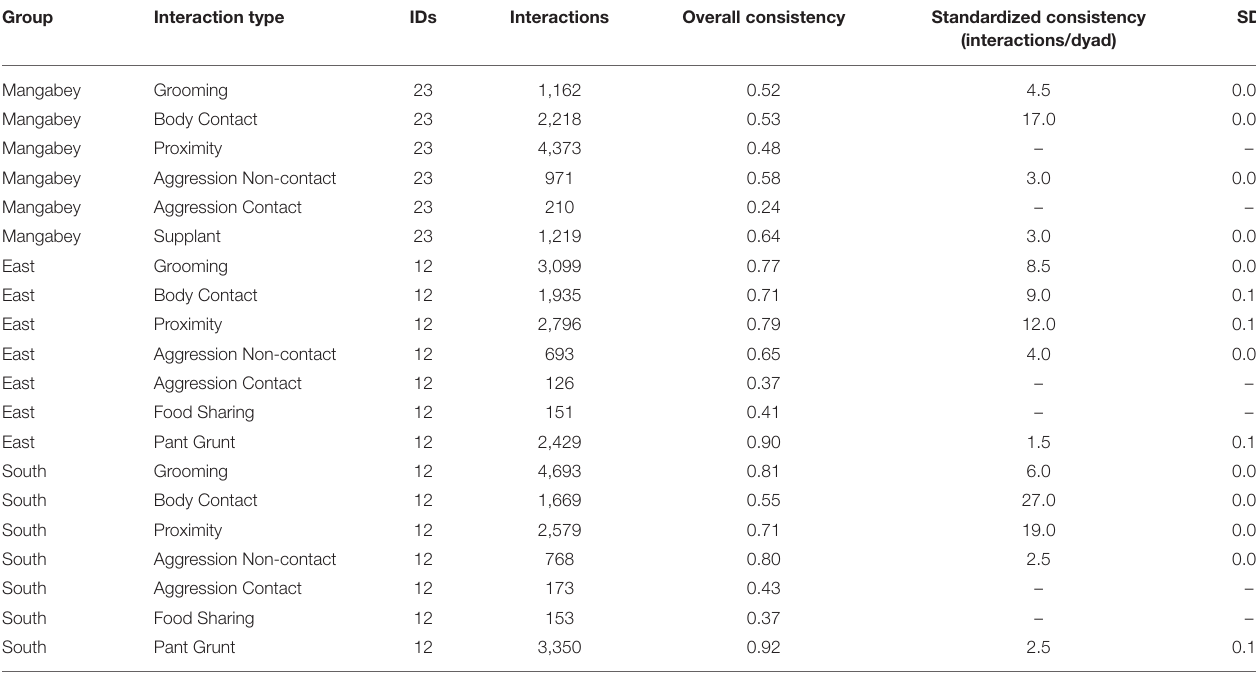
TABLE 1 | Overview of consistency scores in chimpanzee and mangabey social interactions: datasets for each interaction type and group, and the results of the consistency measures. Group